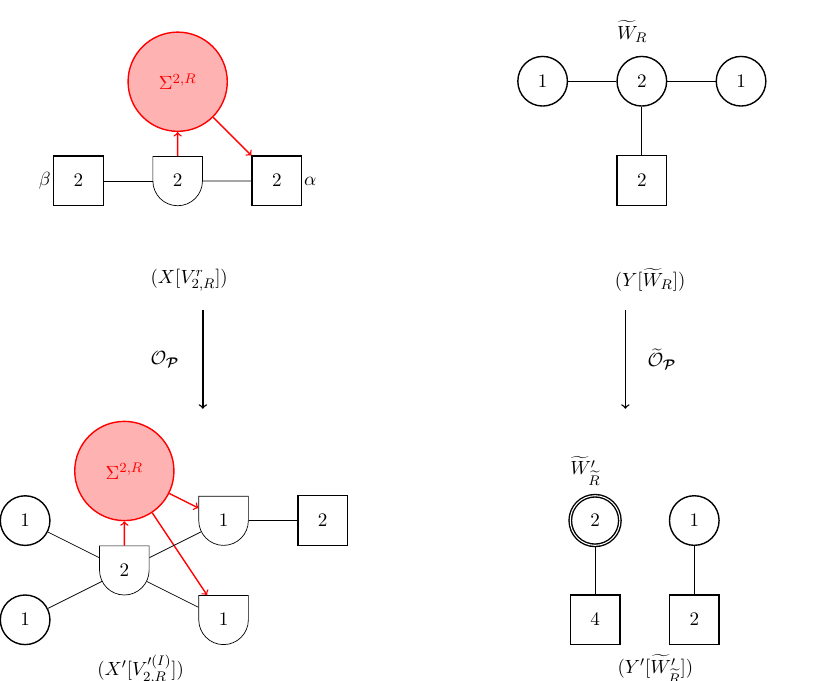
Figure 63 . Construction of a vortex defect in the central U(2) gauge node of the theory X 0 and its dual Wilson